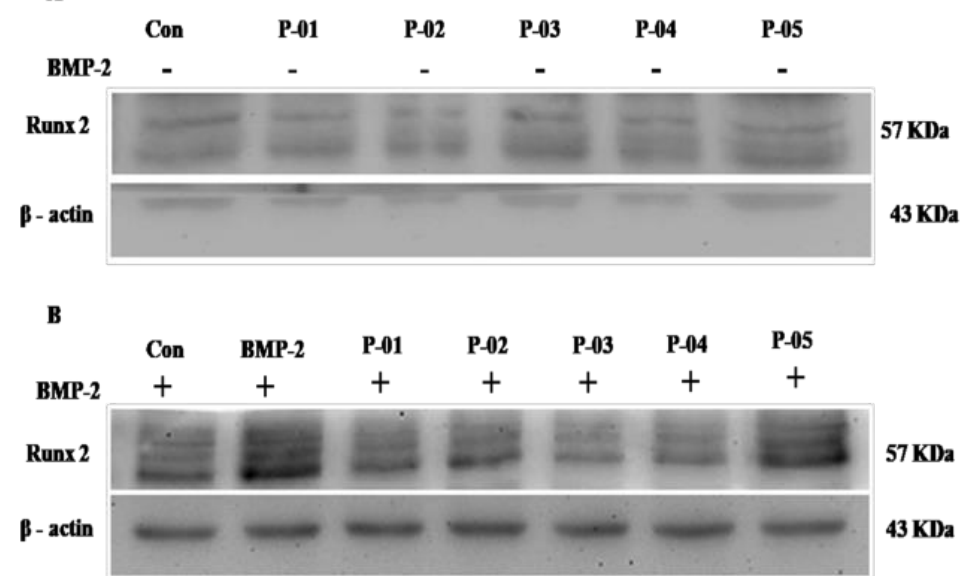
Figure 4. Western blot performed using the C2C12 cell line, with the blots treated using antiRUNX2 antibody. ( A ) Western blot of the RUNX2 expression of the control (without any treatment) and the different kinds of peptides (P-01 to P-05). ( B ) Western blot of the RUNX2 expression of the combination of the protein (2.5 nM) and peptides (500 nM) P-01 to P-05.